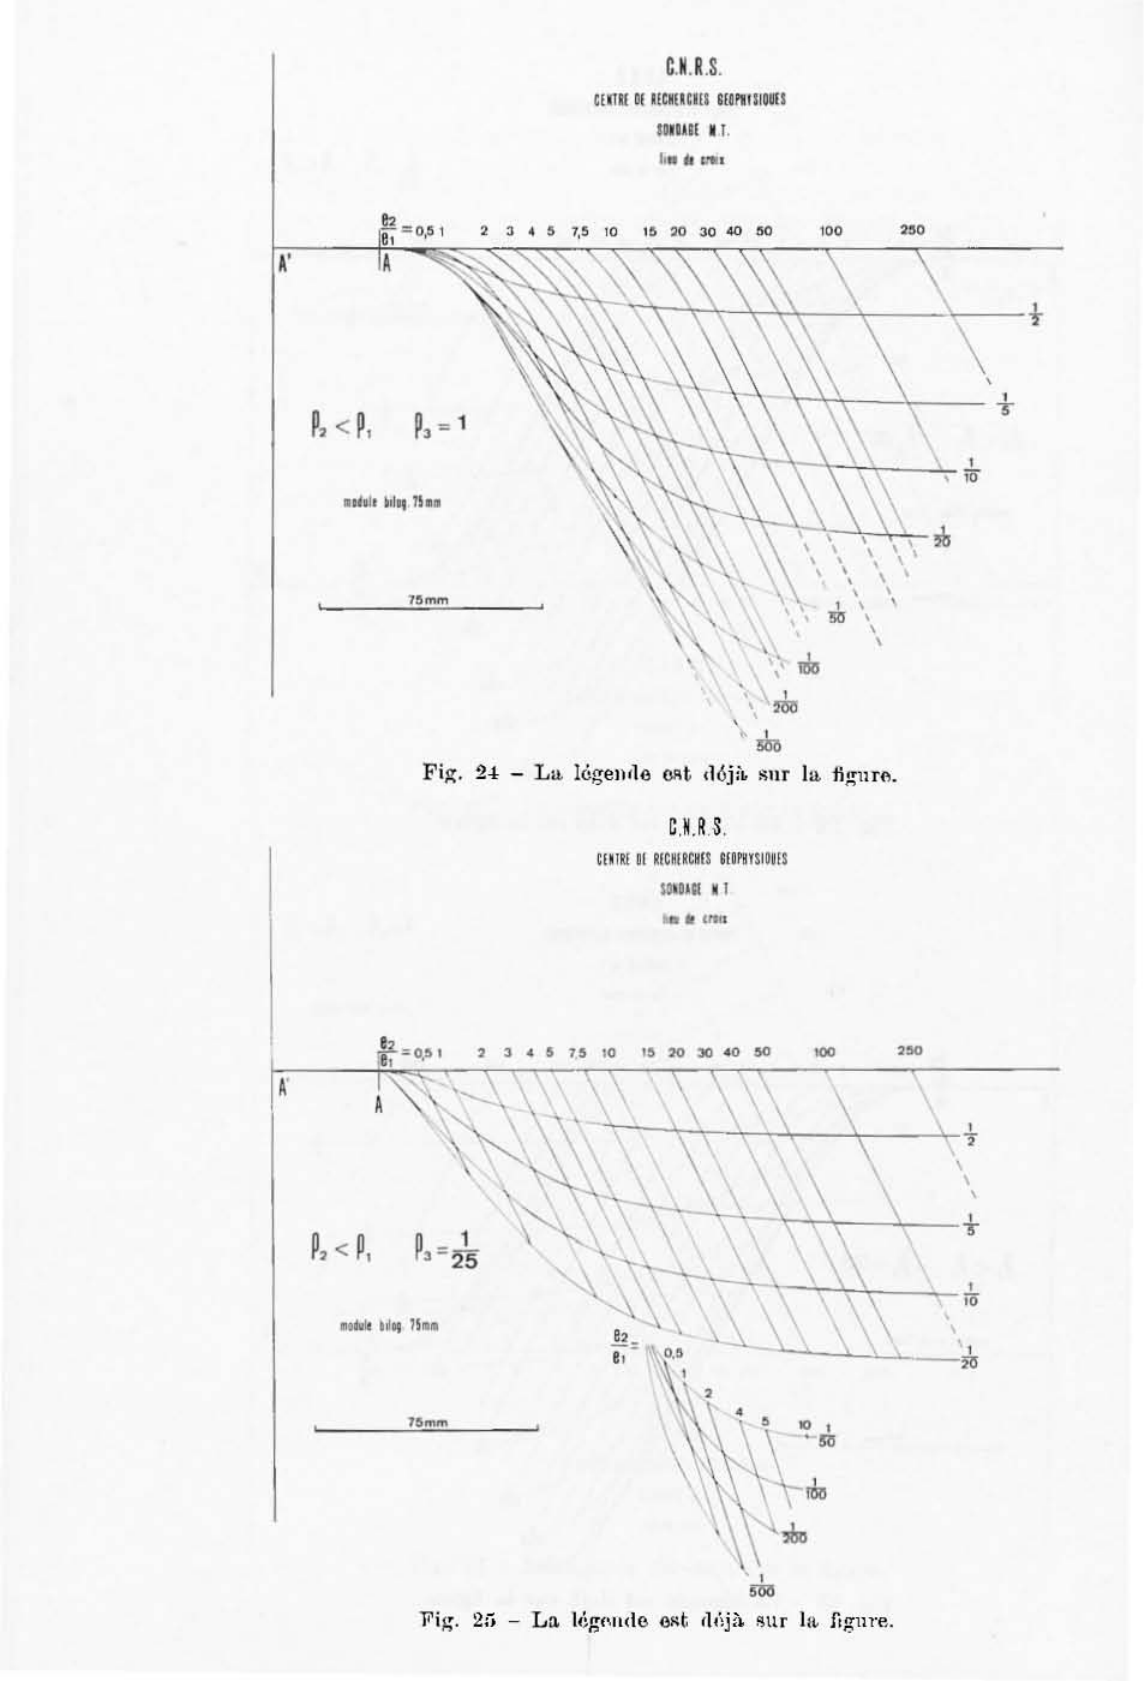
Fig. :!-t- - La Ié,,«ell/lo OIIt ,16jlì. lmr 111